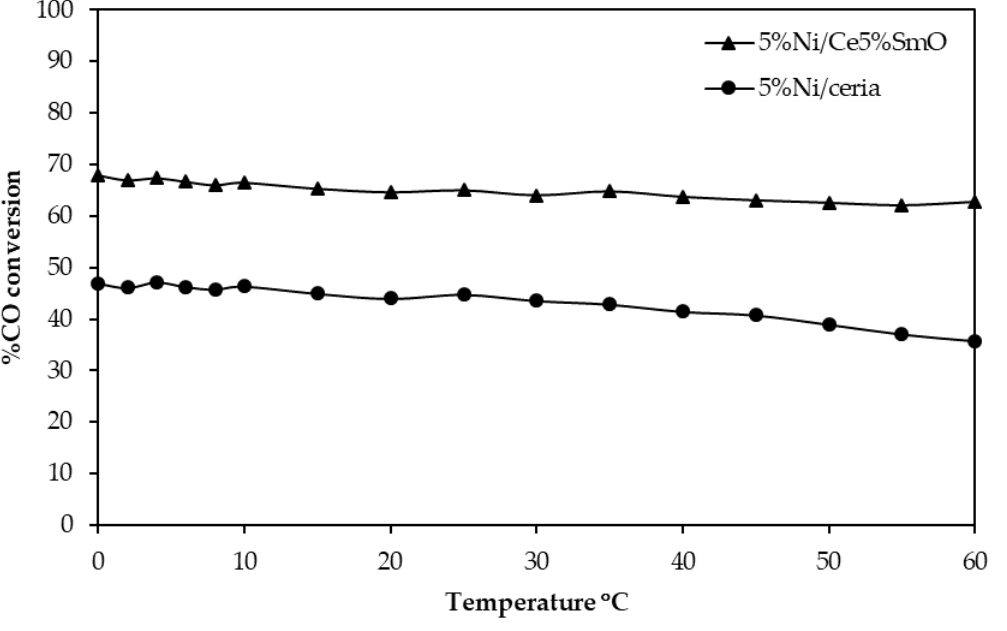
Figure 7. Long term stability test at 280 °C for supported Ni catalysts prepared by combustion method.